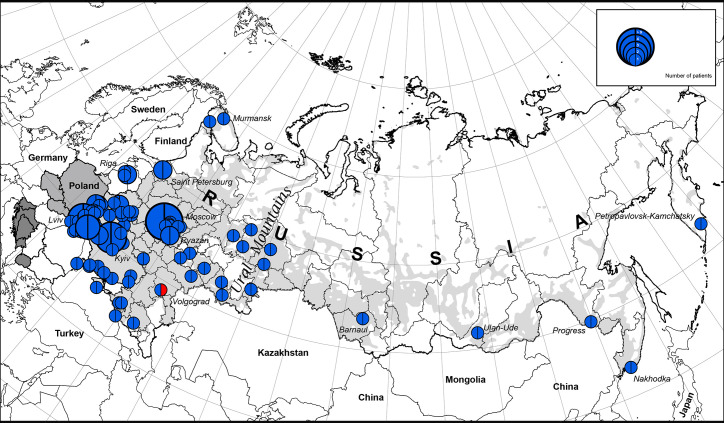
The geographic distribution of NBS patients among East Slavs. Light gray zone on the map of Russia is the territory of predominant Russian settlement (18). The size of the full circle correlates to the number of patients diagnosed from one location (or region) (range 1 to 9). In blue is the NBN founder variant c.657_661del5, p.K219fsX19; in red: NBN c.657_661del5/c.681delT.